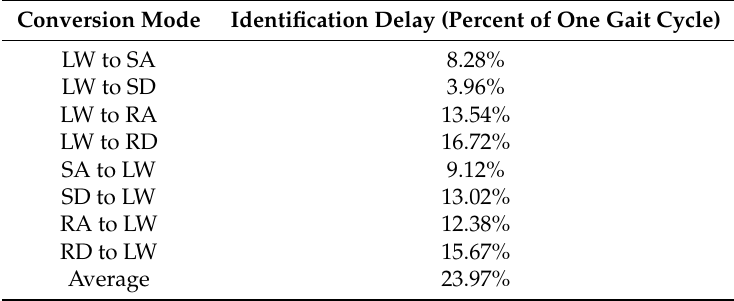
Table 2. Identification delay of locomotion